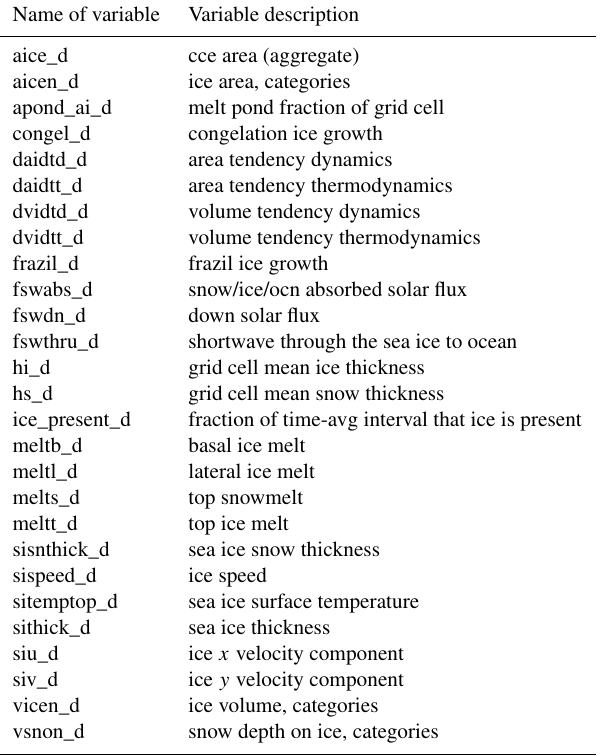
Table A10. Daily averaged output from the sea ice model in ARISE-SAI-1.5 simulations and all SSP2–4.5 CESM2(WACCM6)